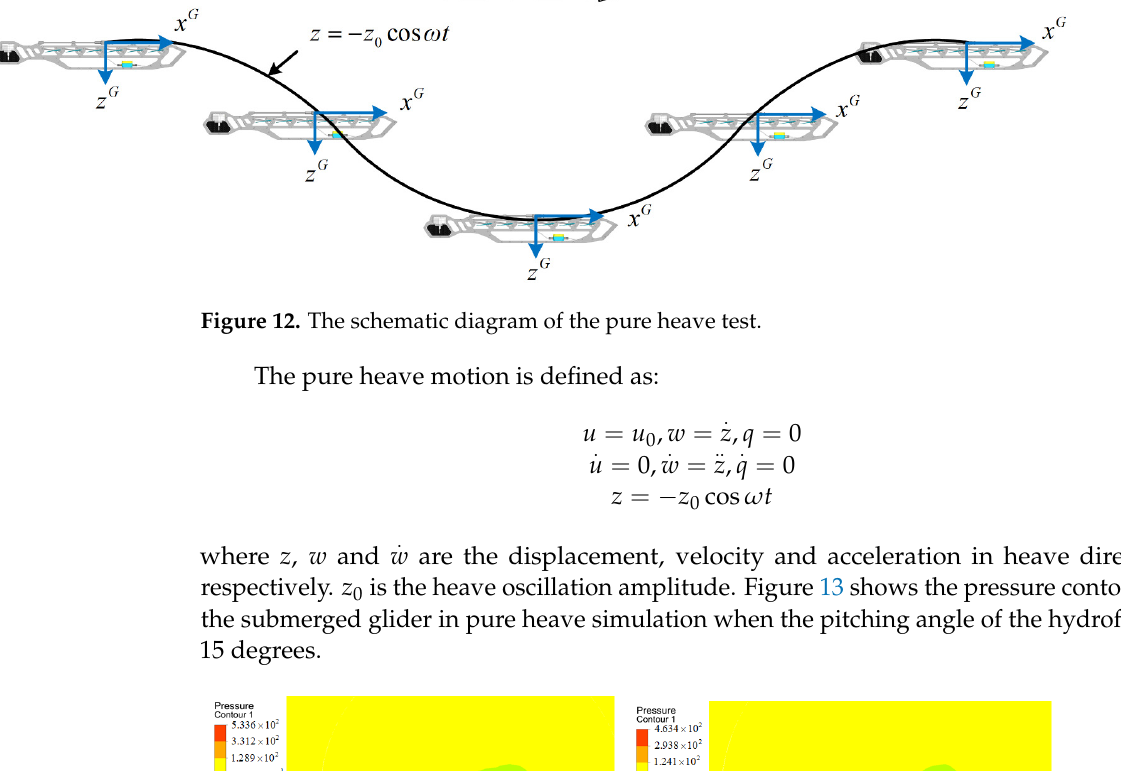
Figure 13. The pressure contours of the submerged glider in pure heave simulation ( θ G =15 Substituting Equation (40) into Equation (37), the hydrodynamic forces and